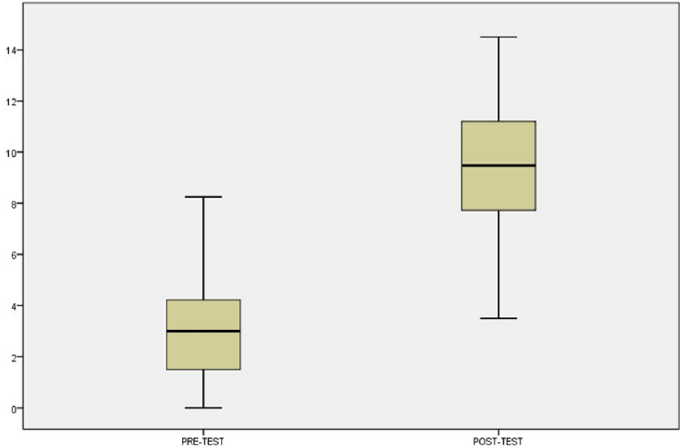
Figure 4. Pre-test and post-test of CS1 students after using Guided TPACK VEE. Table 6. Descriptive statistics of results of students.